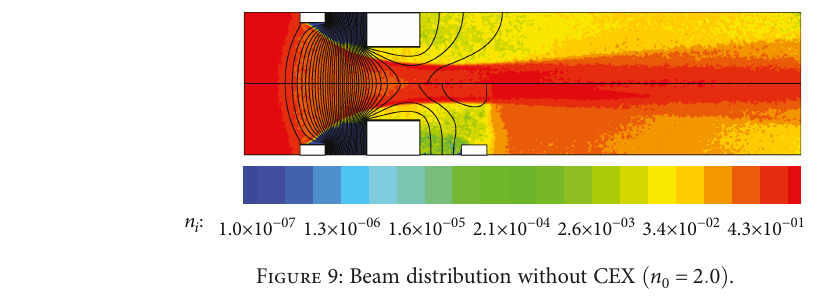
Figure 9: Beam distribution without CEX n